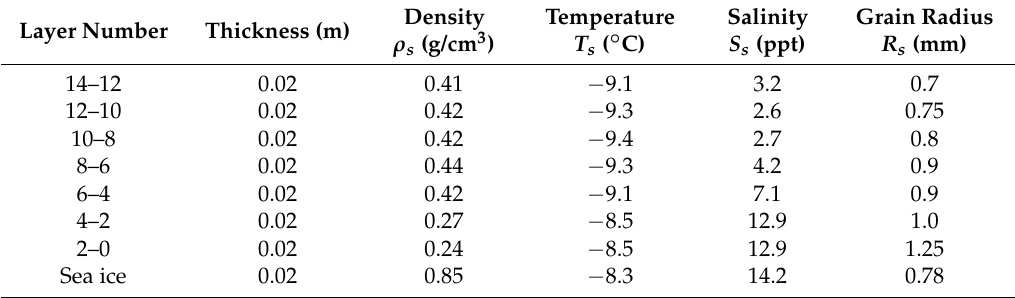
Table 2. Snow cover and sea ice thermophysical properties for the 8 cm snow cover on smooth FYI for 19 May 2012. The total sea ice thickness was 1.3 m, and “sea ice” in the table represent the topmost 2 cm frazil ice core section.